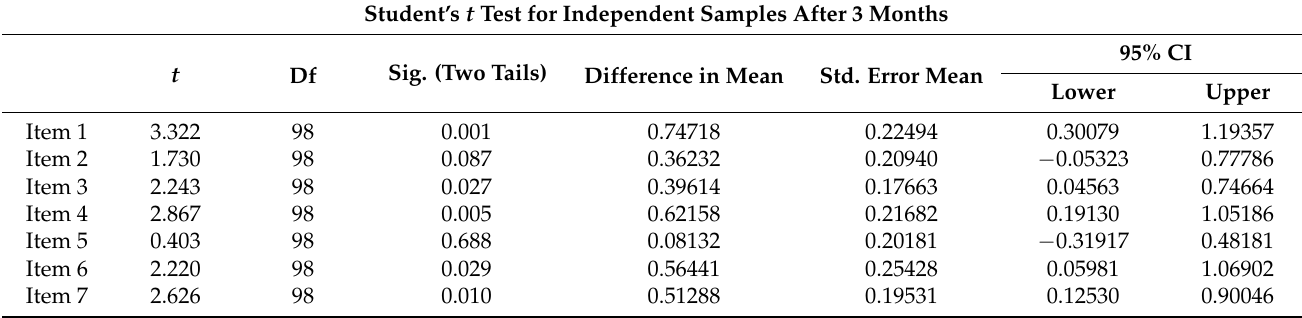
Table 4. Comparison between the two groups after the educational intervention.